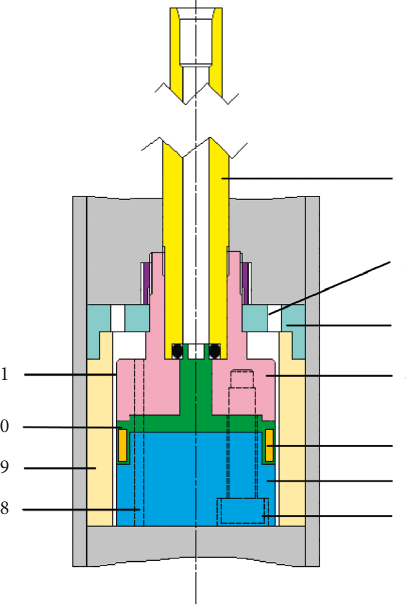
Figure 27: Cross-sectional view of a piston portion of a MR damper with bypass hole:1, piston rod; 2, main holes; 3, end part; 4, the first core; 5, electromagnetic coil; 6, the second core; 7, bolts; 8, bypass hole; 9, flux ring; 10, coil assembly; 11, annular main clearance [86].